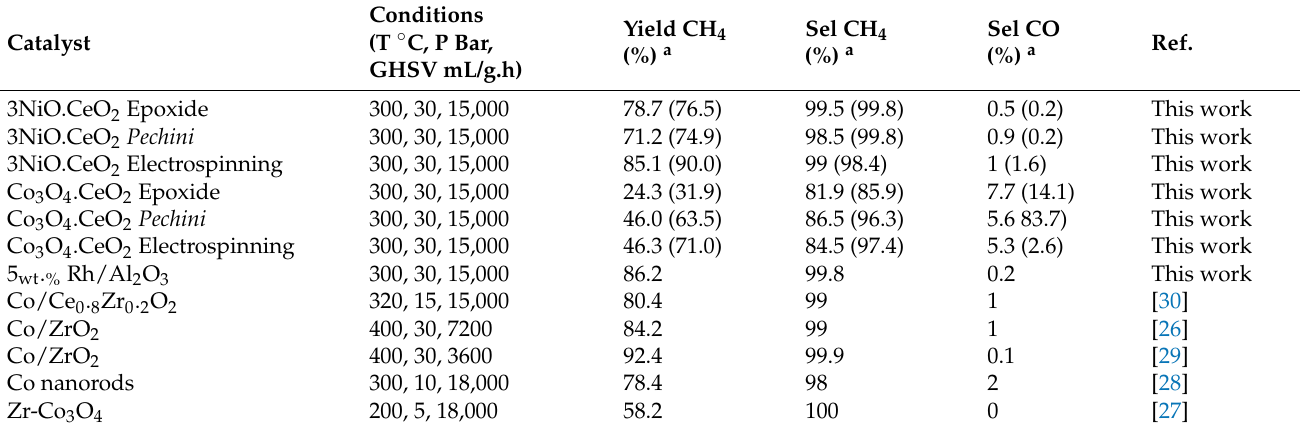
Table 2. Comparison of catalysts’ activity.